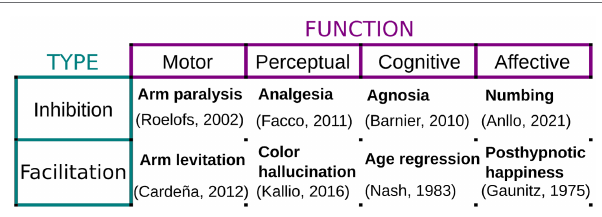
FIGURE 1 | Examples of hypnotic suggestions. Hypnotic and posthypnotic suggestions can either inhibit or facilitate a vast array of motor, perceptual, cognitive, and affective responses. Examples are provided together with studies evaluating their implementation and